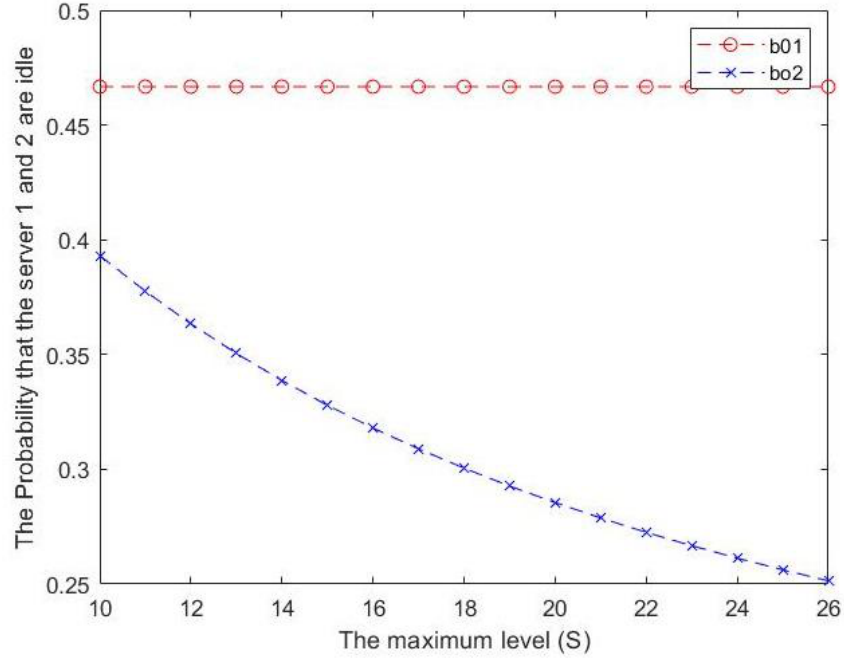
Figure 8. Effect of S on the probability that servers 1 and 2 are